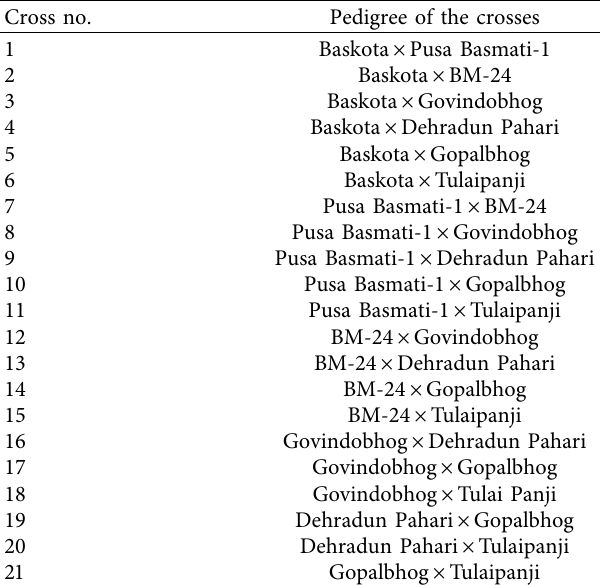
Table 2: List of crosses involving seven parents. Cross